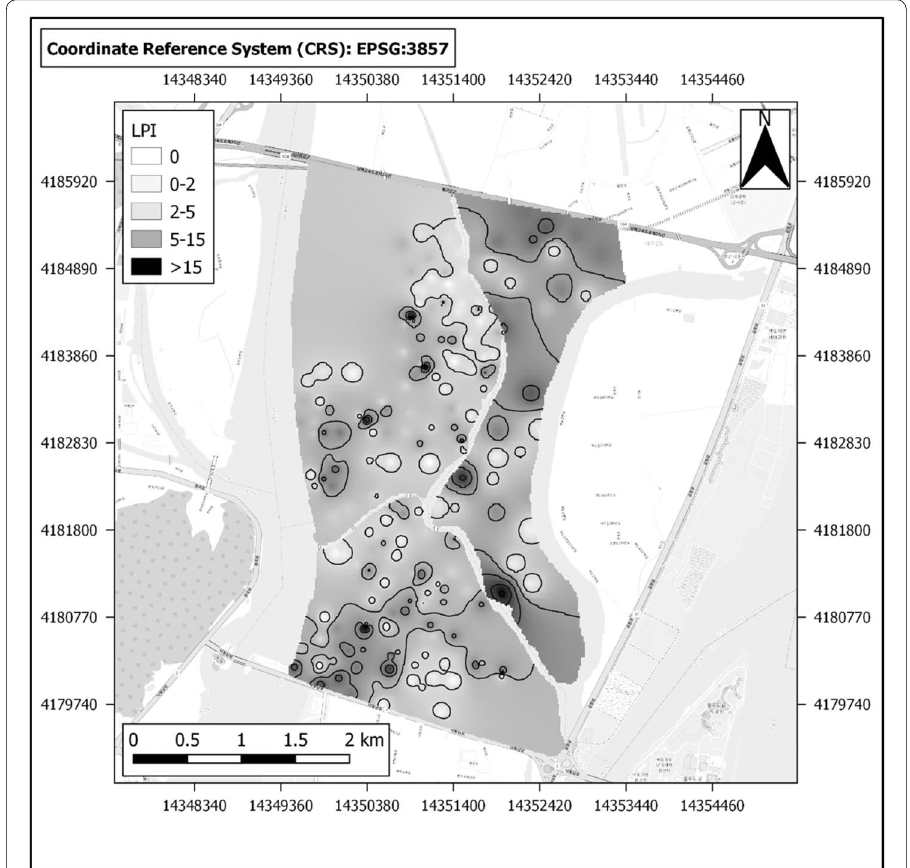
Fig. 17 Liquefaction hazard map based on DSHB [8] method for case